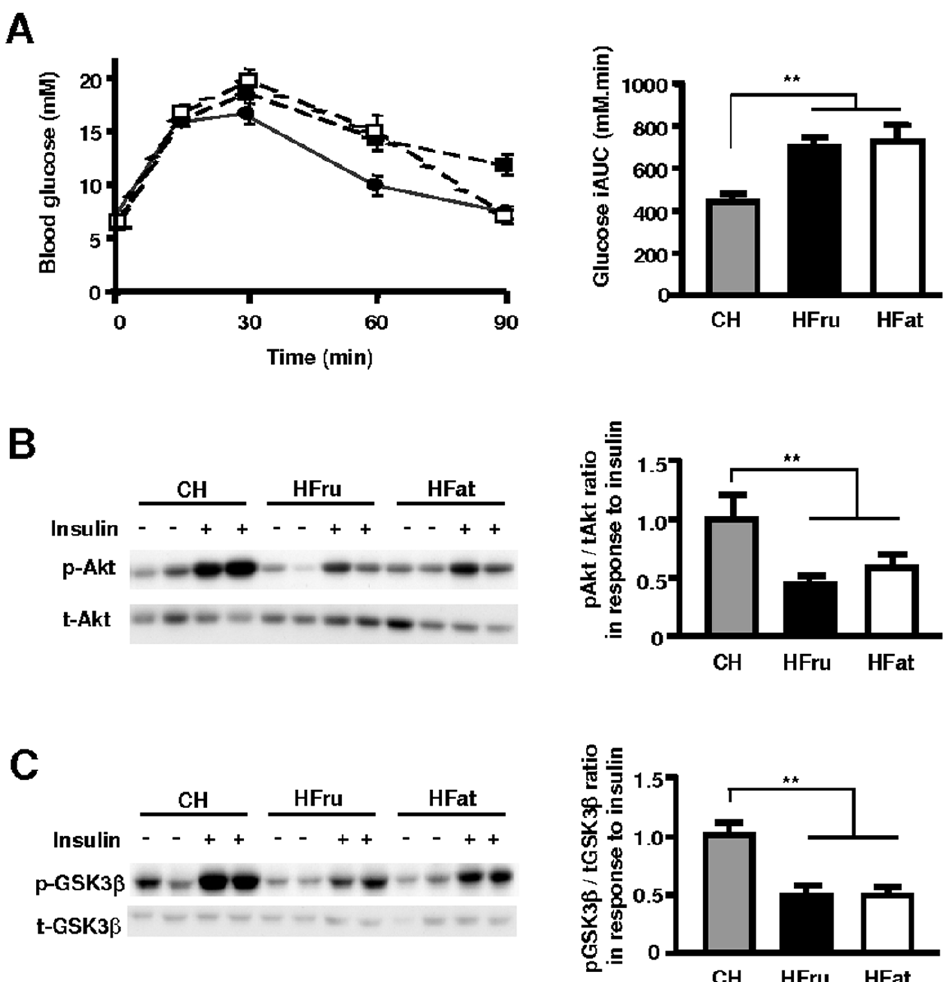
Figure 2. Effects of HFru and HFat feeding on glucose tolerance and hepatic insulin signal transduction. The experiments were performed after one week of high fructose (HFru, & ), high fat (HFat, % ) or chow (CH, N ) feeding. ( A ) Glucose tolerance test (GTT) was performed with an injection of glucose (3 g/kg, ip ) after 5–7 hours of fasting. Data are mean 6 SE, 6–10 mice per group. iAUC, incremental area under the curve for blood glucose level. Insulin signal transduction was assessed by immunoblotting of phosphorylated-Akt (Ser473) ( B ) and -GSK3 b (Ser219) ( C ) in the liver in response to a bolus of insulin stimulation (2 U/kg, ip ). Each lane represents a single mouse. Densitometry data are mean 6 SE of 6 mice per group. ** p , 0.01.